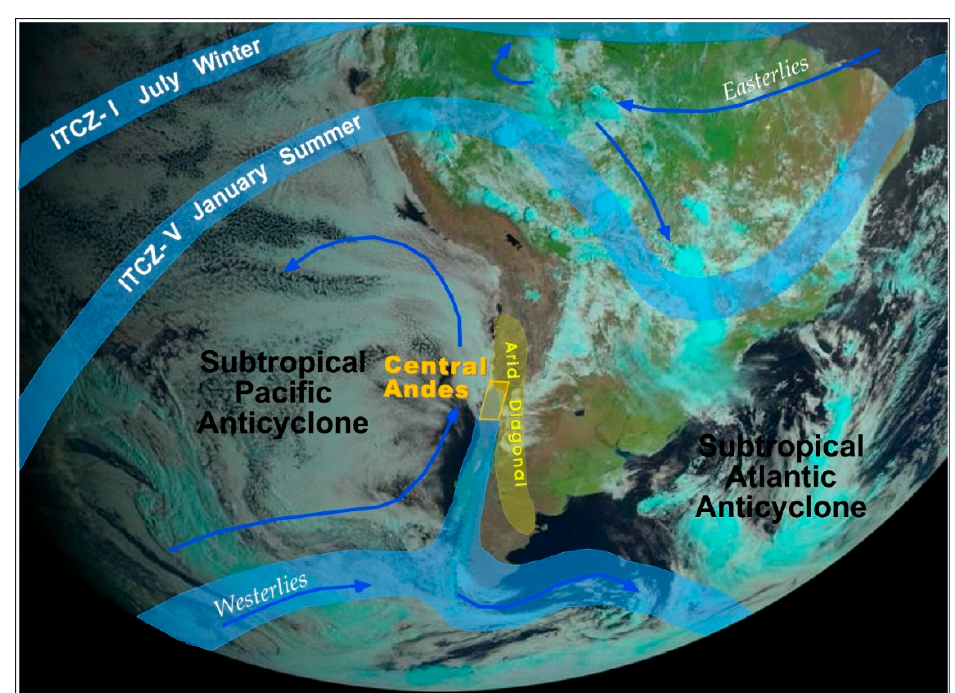
Figure 1. Climate framework settings of the study area showing the location of the Intertropical Convergence Zone (ITCZ) in summer and winter seasons forcing the humidity incomes (precipitations) from Atlantic or Pacific Anticyclones. Image corresponds to Goes-16 (Geostationary Operational Environmental Satellite) by the National Oceanic and Atmospheric Administration (NOAA) [29].